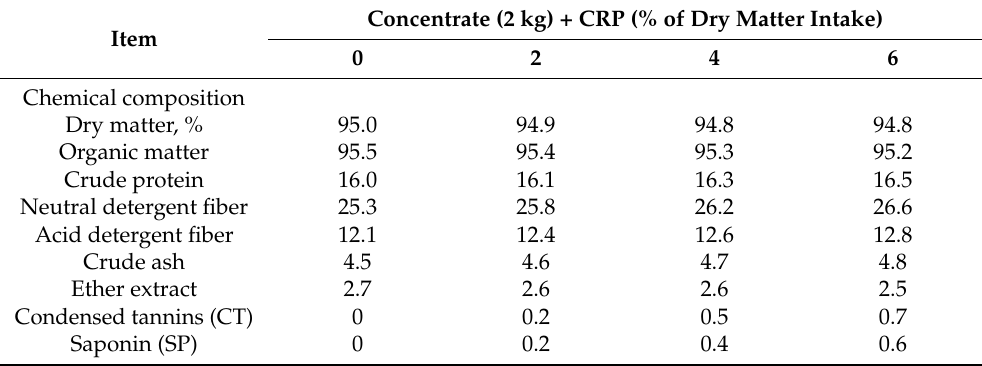
Table 2. Composition of concentrate plus chaya powder plus rambutan peel powder pellet